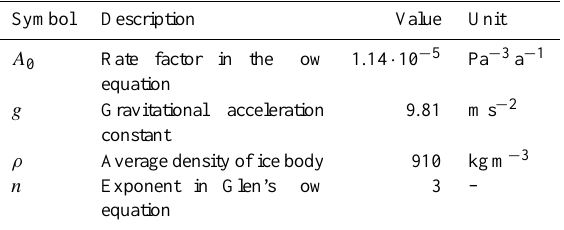
Table 1. Overview of model parameters used in the ISMIP-HOM benchmark (Pattyn et al., 2008). Symbol